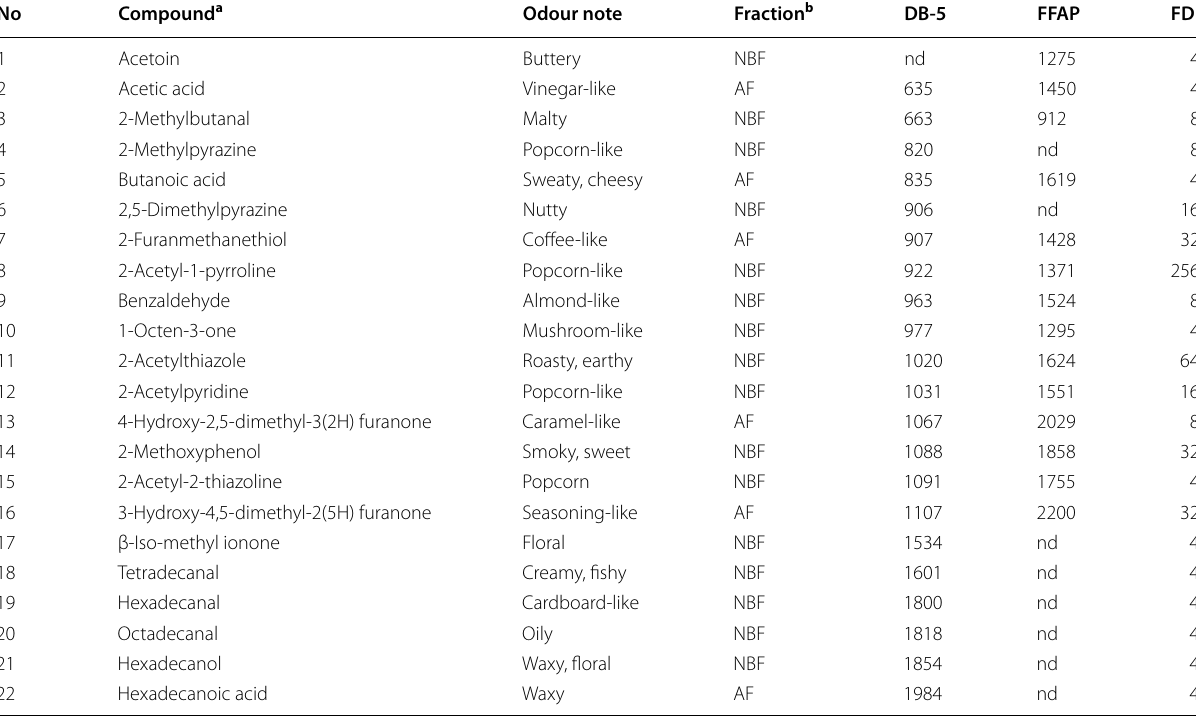
4) in Fried giant snail meat ( A. fulica ) ≥